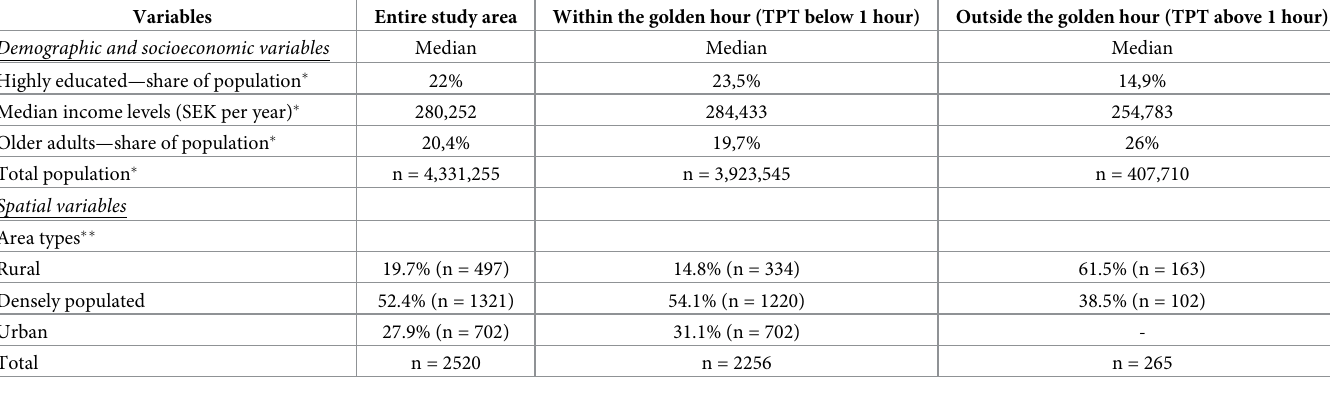
Table 1. Descriptive statistics for the socioeconomic, demographic and area type